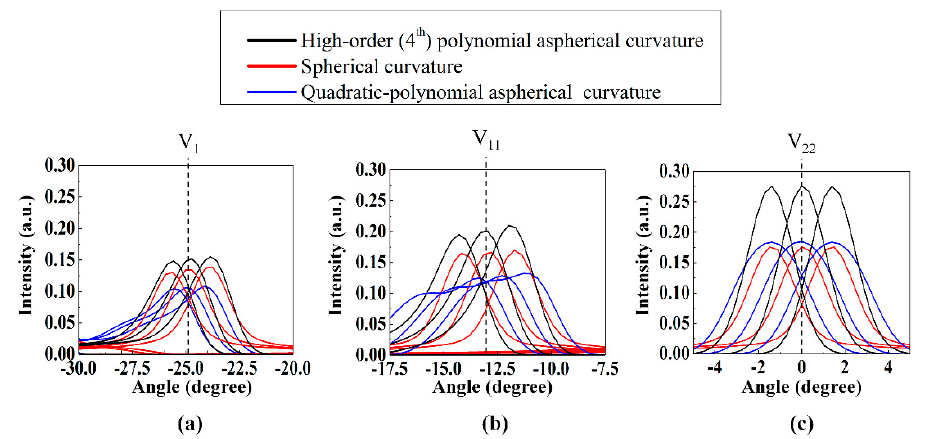
Figure 11. Angular luminance distributions for different interfacial curvatures. The luminance distribution for the selected view is co-plotted with those of two adjacent views. The selected views are ( a ) the viewing window edge (V 1 at − 24.6°), ( b ) oblique mid-view (V 11 at − 12.9°) within the viewing window, and ( c ) normal view (V 22 at 0°).